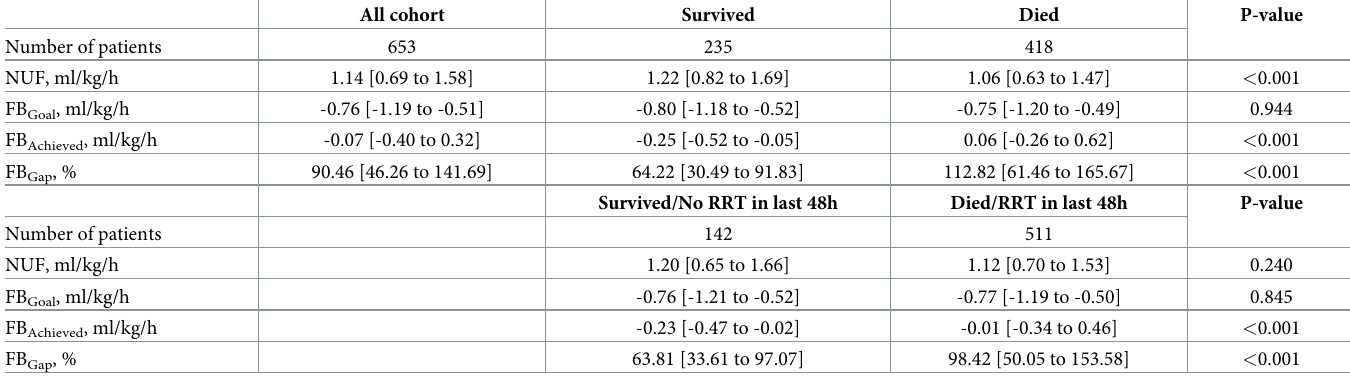
Table 2. CRRT parameters reflecting fluid management during CRRT in the whole cohort and according to study outcomes. All cohort Survived Died